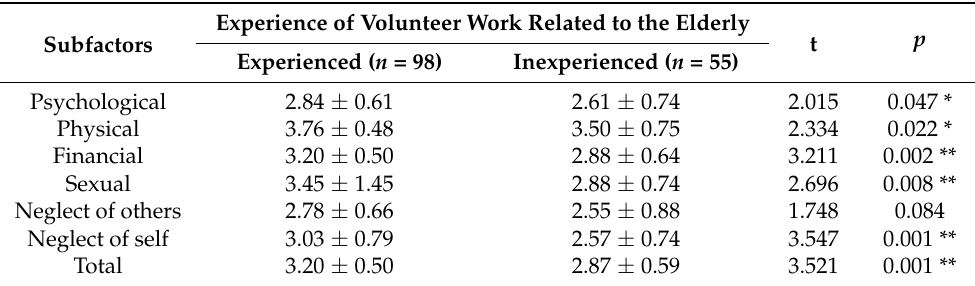
Table 4. Perceived degrees of violation of human rights of the elderly according to the experience of volunteer activities related to the elderly M ± SD.